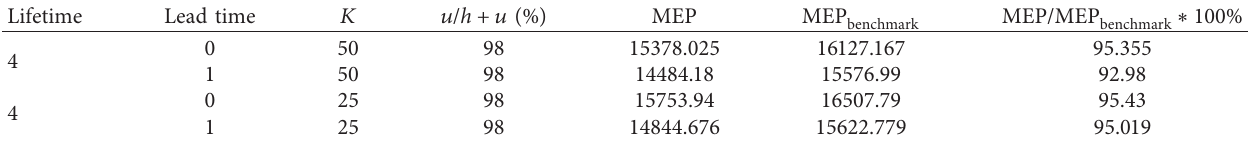
Table 16: MEP with fixed ordering